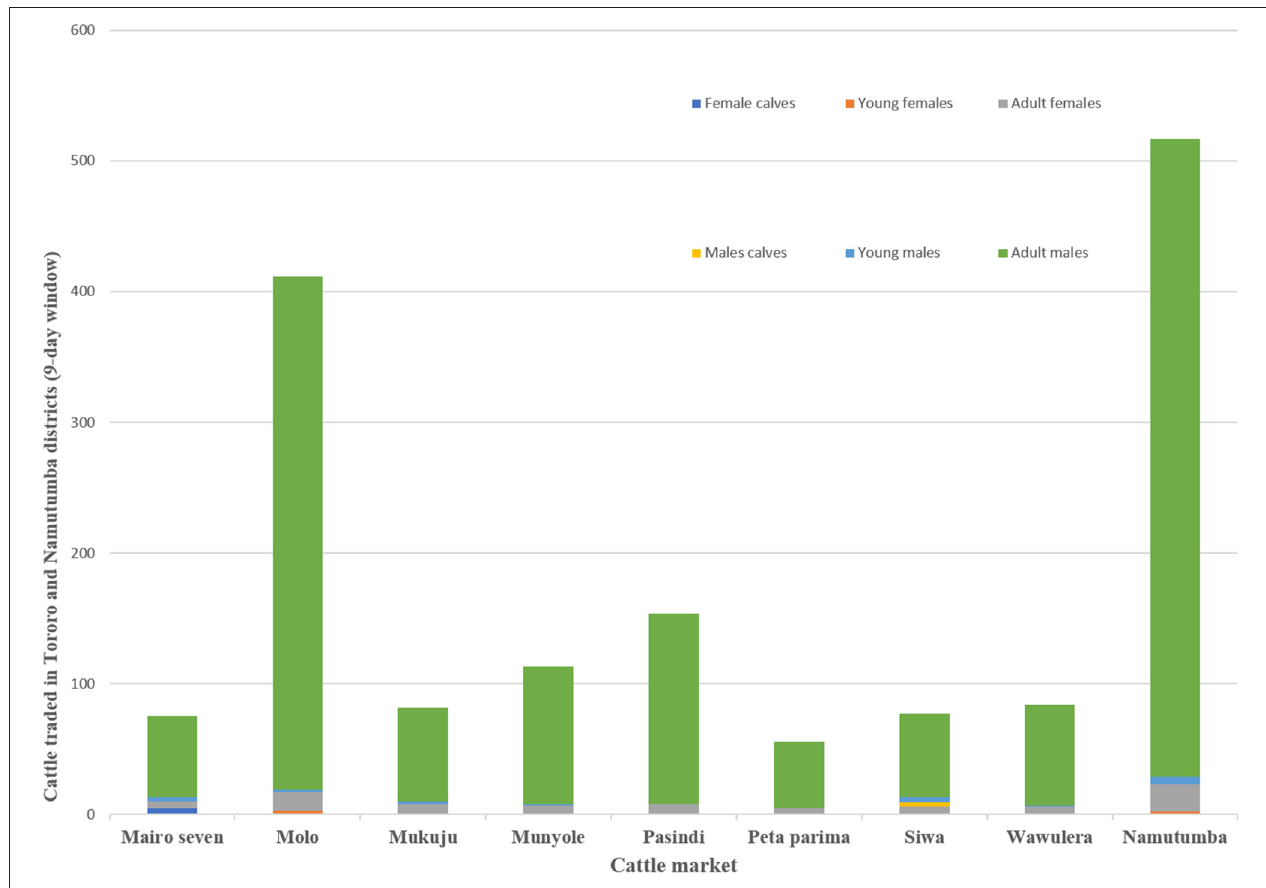
FIGURE 4 | Cattle traded in Tororo and Namutumba Districts (9-day window).